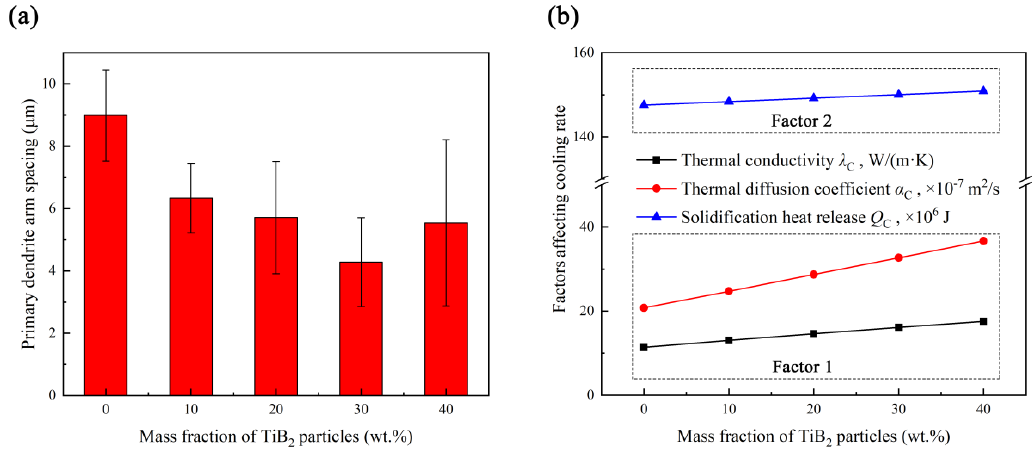
with di ff erent TiB 2 particles Figure 7. ( a ) Primary dendrite arm spacing distribution and ( b ) cooling rate influence factors of coatings with different TiB 2 particles content.